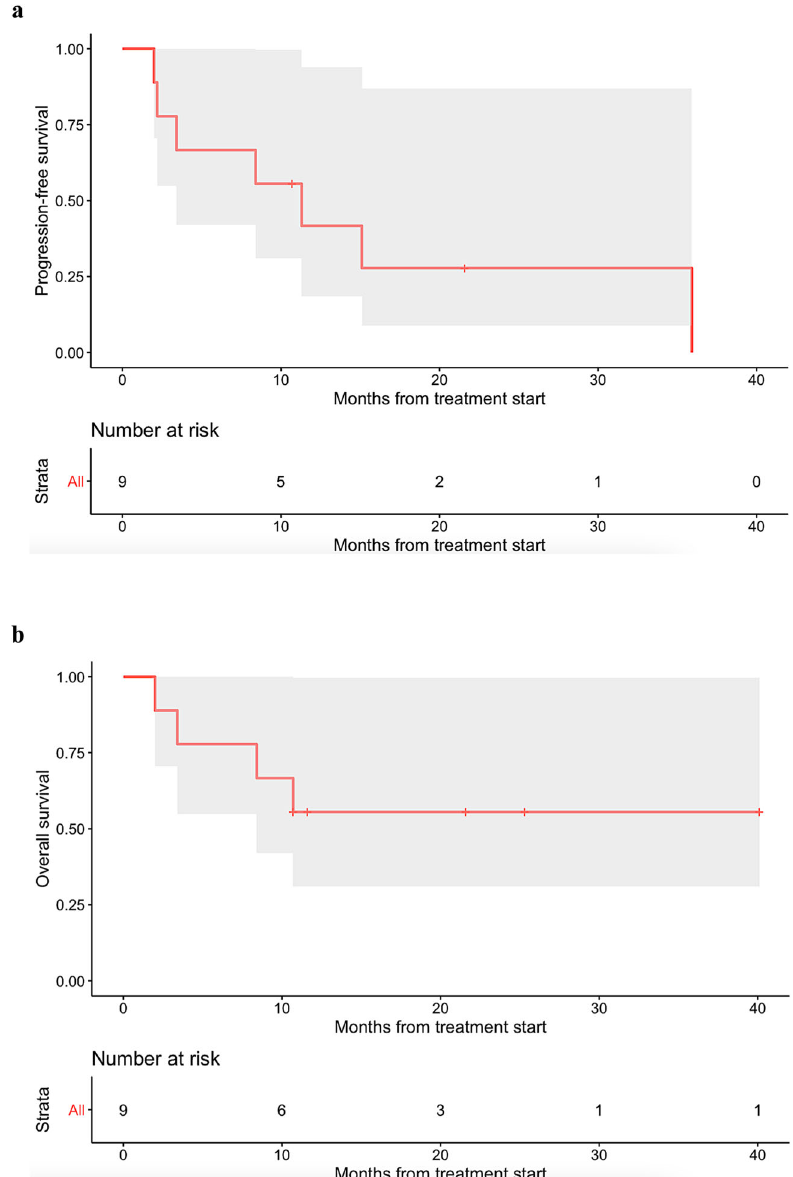
Fig. 2 Kaplan – Meier analysis of nine patients with single pathway alterations matched to targeted therapies. The gray shade areas represent the 95% con fi dence intervals, and bars denote censored observations. Median PFS was 11.3 months (95% CI: 3.4 – not evaluable) ( a ), while median OS was not reached (95% CI: 8.4 – not evaluable) ( b